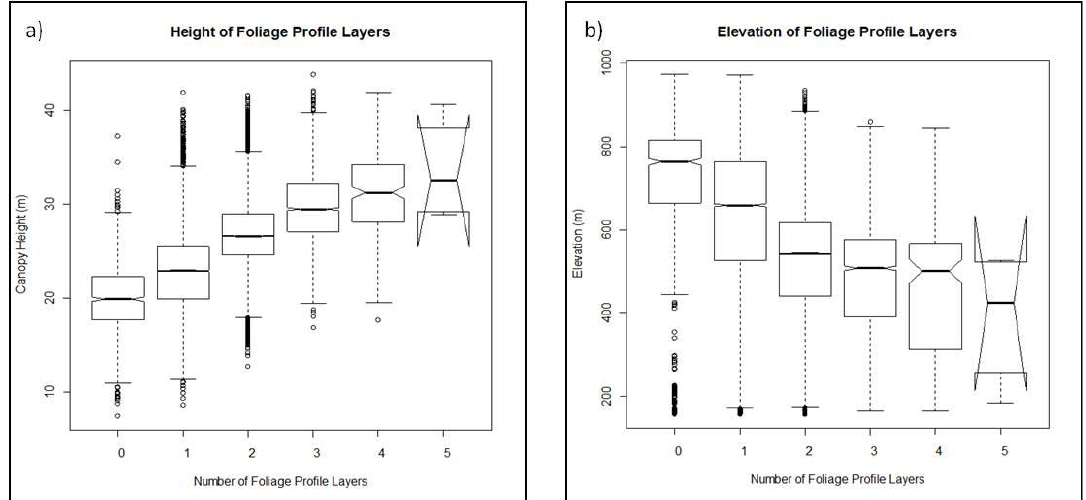
Figure 11. Box plots showing the canopy height ( a ) and elevation ( b ) distribution for each number of foliage profile layers. The boxes represent the interquartile range, with whiskers defining the range of heights within 1.5 times the upper and lower quartiles. The box plot for 5 layers has calculated notches that extend past the interquartile range, showing that the confidence of the median is wider than the range of the data. This is probably because of the group’s small sample size of 4